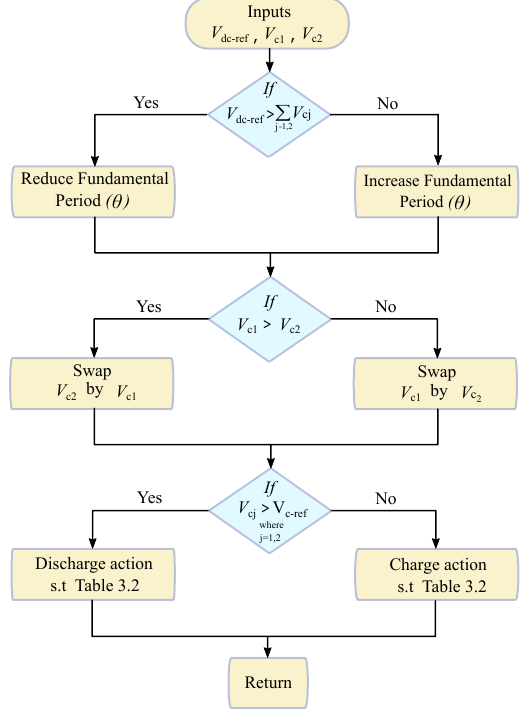
Figure 7. DC-link capacitor voltage balancing